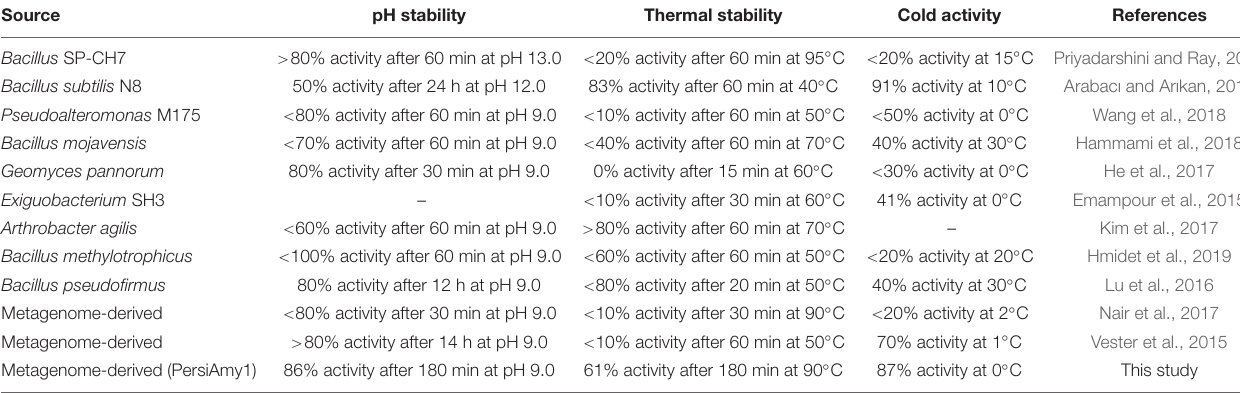
TABLE 3 | Property comparison of PersiAmy1 with some known cold-active and/or alkaline α -amylases.